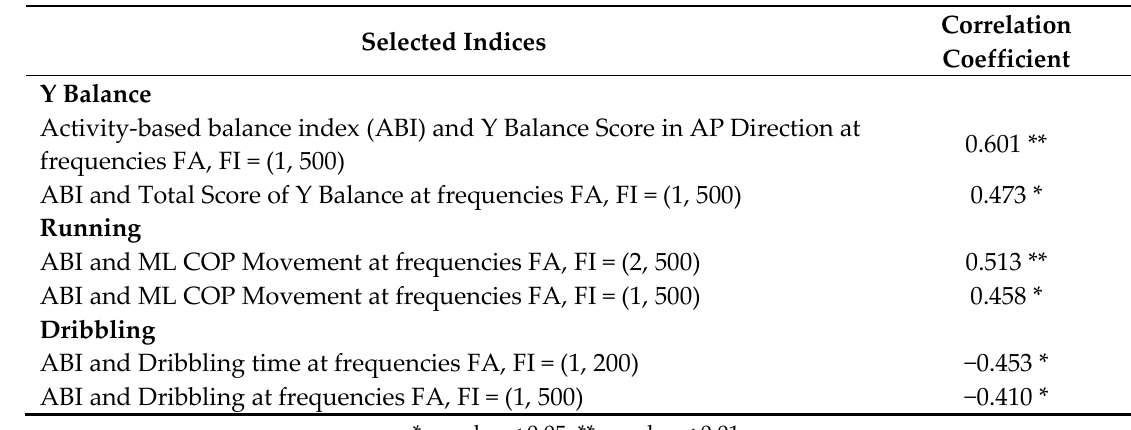
Table 4. The values of correlation coefficients and their significance between selected indices and the results of their corresponding activity tests and